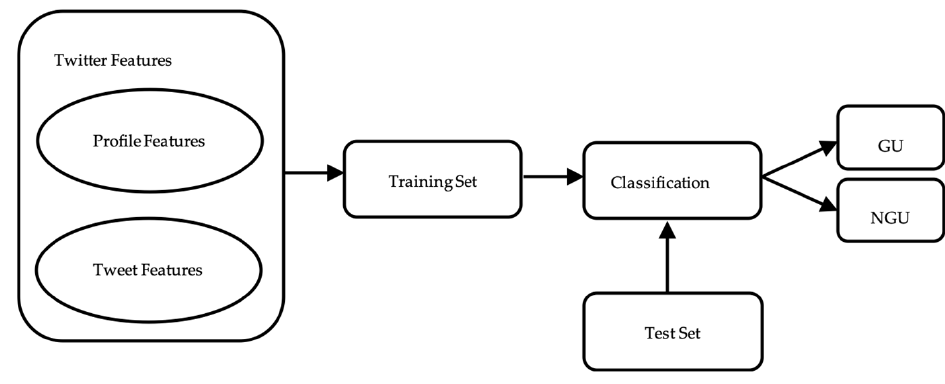
Figure 3. Classification framework.